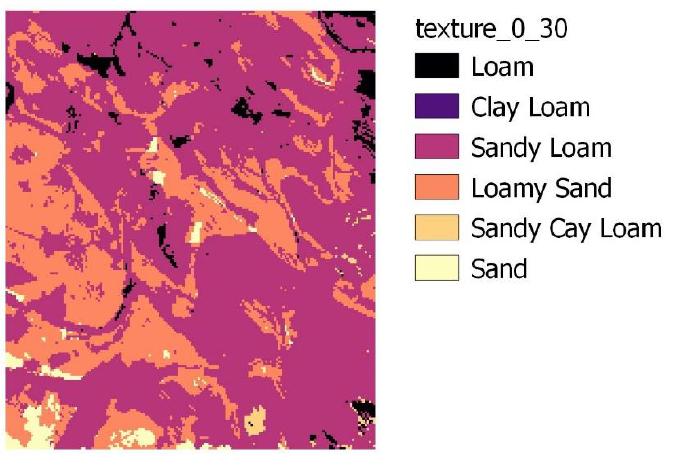
Figure 2. Texture map up to 30 cm soil depth, based on DOSoReMI.hu data [30].